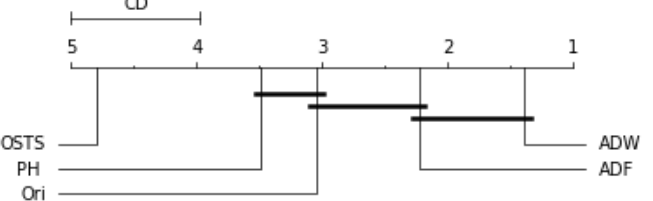
Figure 7. Comparison of the RMSE values obtained by segmentation techniques for ARIMA predictor according to the Nemenyi test. Groups that are not significantly different ( α = 0.05 and CD = 1.03) are connected.